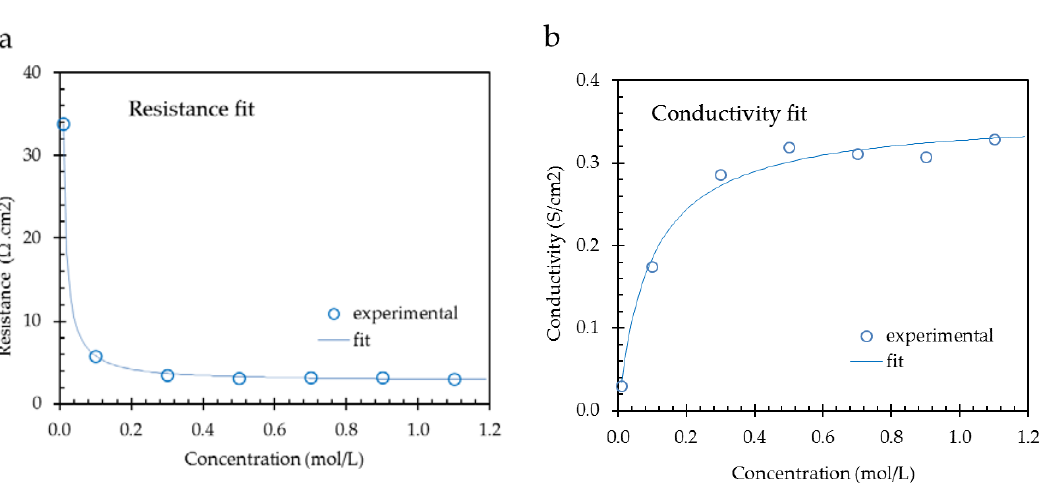
Table 5. Corrected solution contribution b/δ from experiments by Nouri et al. [15].